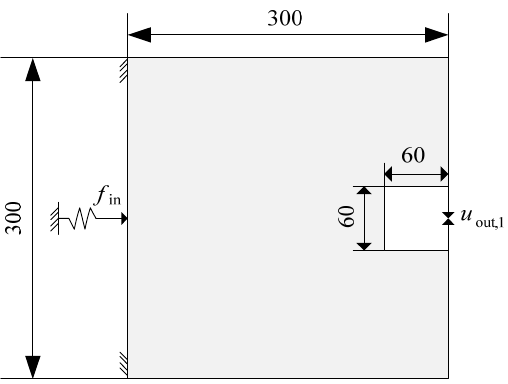
Figure 9. The design domain of a compliant gripper. Table 3. Design parameters for the compliant gripper.